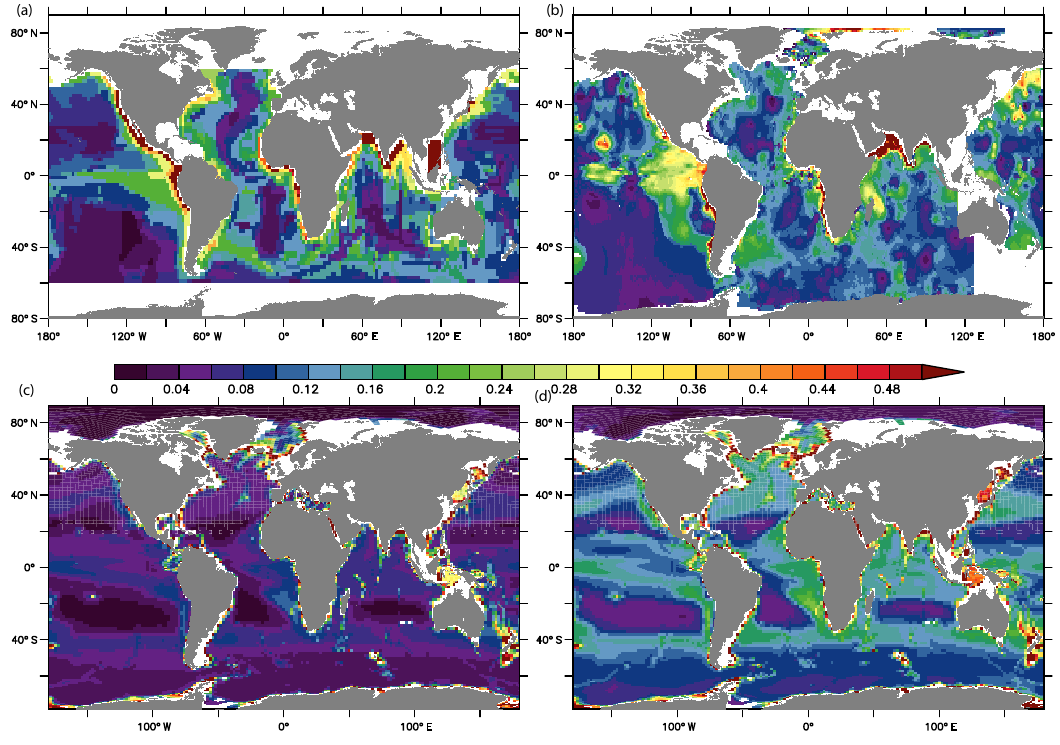
Figure 7. Annual mean POC fluxes (molm − 2 year − 1 ) to the sediments reconstructed (a) from oxygen fluxes (Jahnke, 1996) and (b) from correlations based on the organic carbon content in surface sediments and the bottom oxygen concentrations (Seiter et al., 2005). Panels (c, d) show the corresponding fluxes as predicted in the noRC and RC experiments